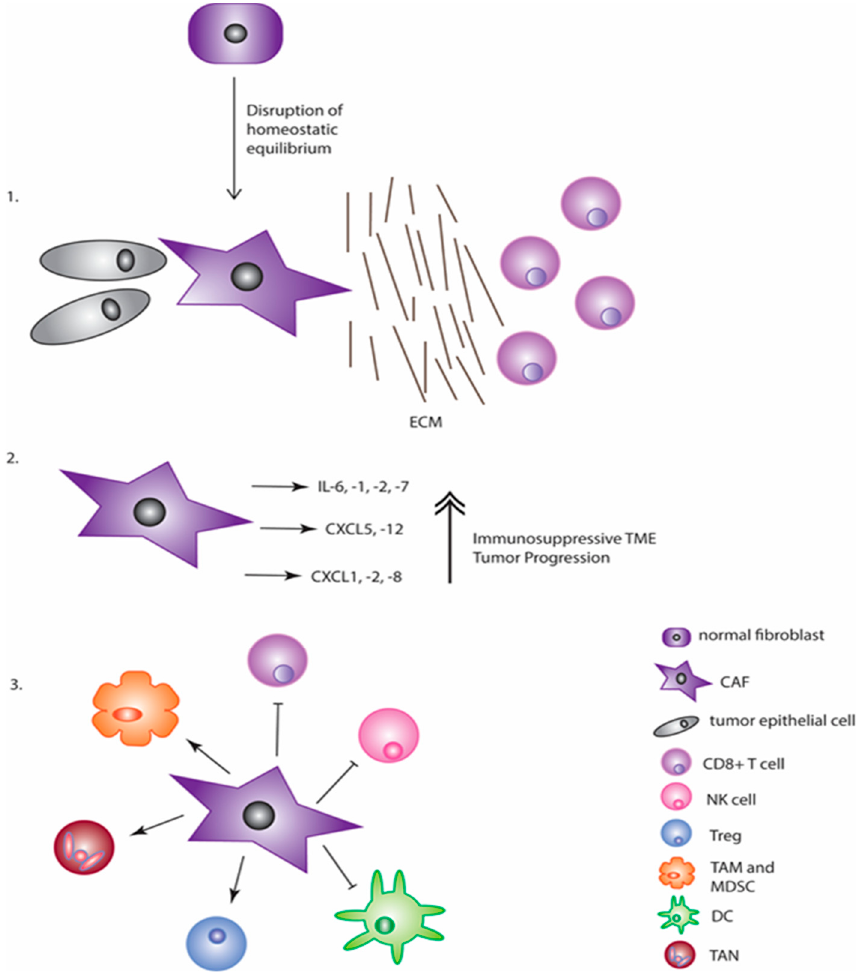
Figure 1. CAFs contribute to an immunosuppressive TME in three major ways. The first is through secretion of ECM proteins that physically separate immune cells (like the CD8+ cytotoxic T cells pictured) from the actual tumor cells. The second is through secretion of critical chemokines and cytokines that aid in both tumor promotion and immune suppression. The third and final way is through suppression of anti-tumor immune cells and promotion of immune cells into the tumor space that dampen the immune response.